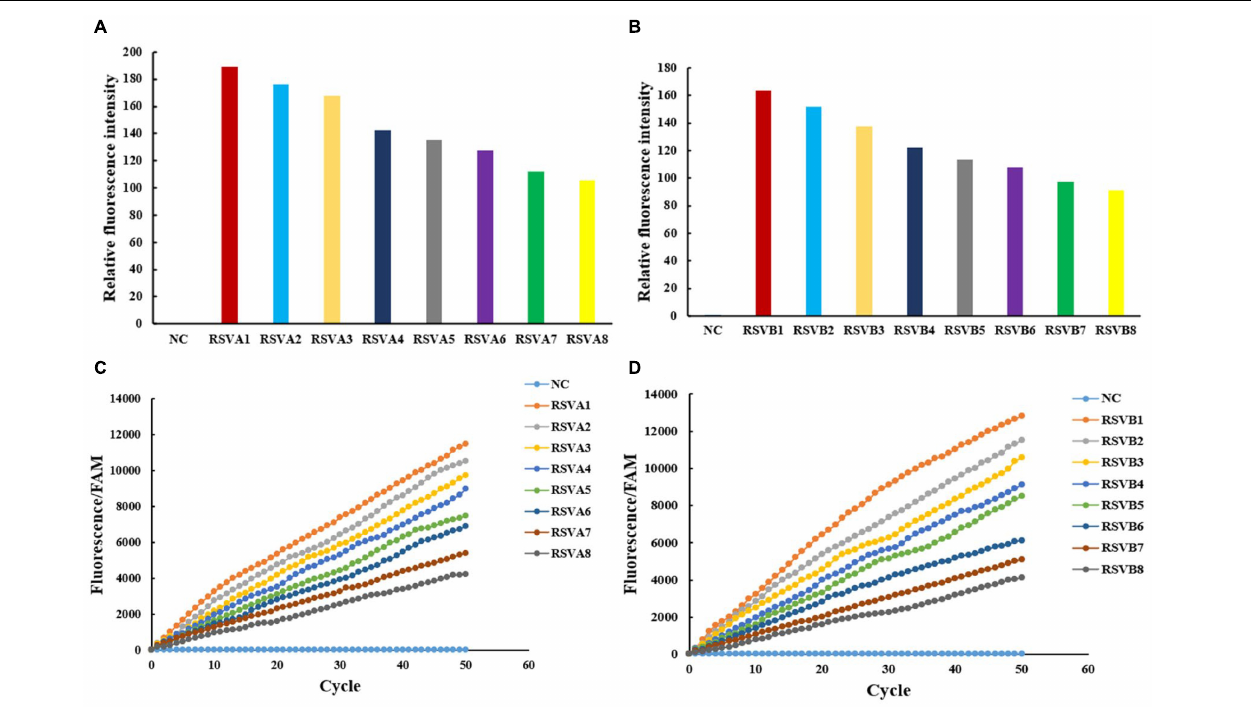
FIGURE 4 | The IT-RAISE system detects RSV A and RSV B. Results were checked using a fluorescence multimode reader (A,B) and a real-time fluorescence PCR machine (C,D) . Information of RSV A1–RSV A8 and RSV B1–RSV B8 is the same as in Figure 3 . NC: FAM and water. All experiments were repeated three times ( n =